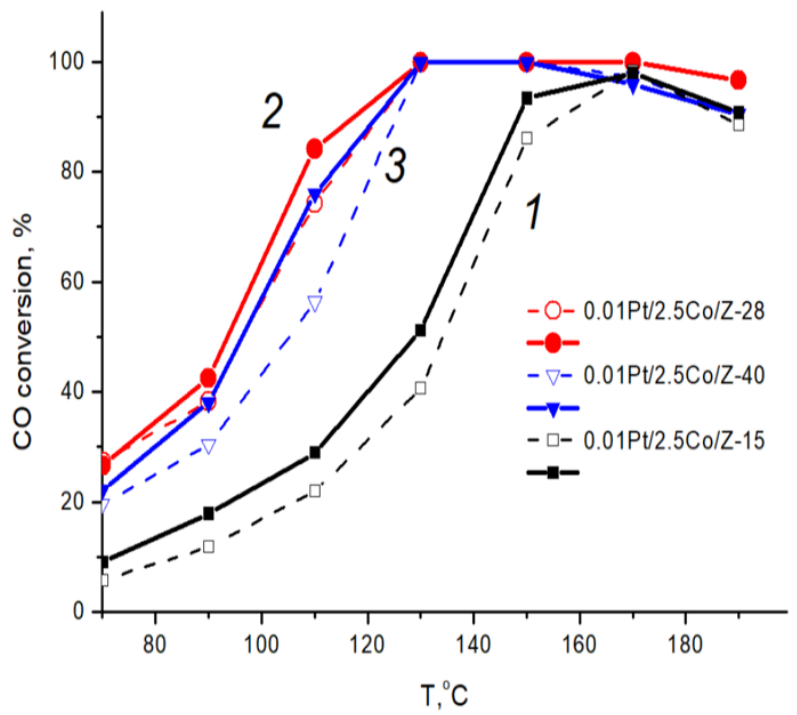
Figure 6. Temperature dependences of the CO conversion for the 0.01Pt/2.5Co/Z on zeolites with Si/Al: 15 (1), 28 (2), 40 (3). Shown are the data for heating–cooling cycles: dotted line and open symbols correspond to the heating cycle while solid line and solid symbols correspond to the cooling.